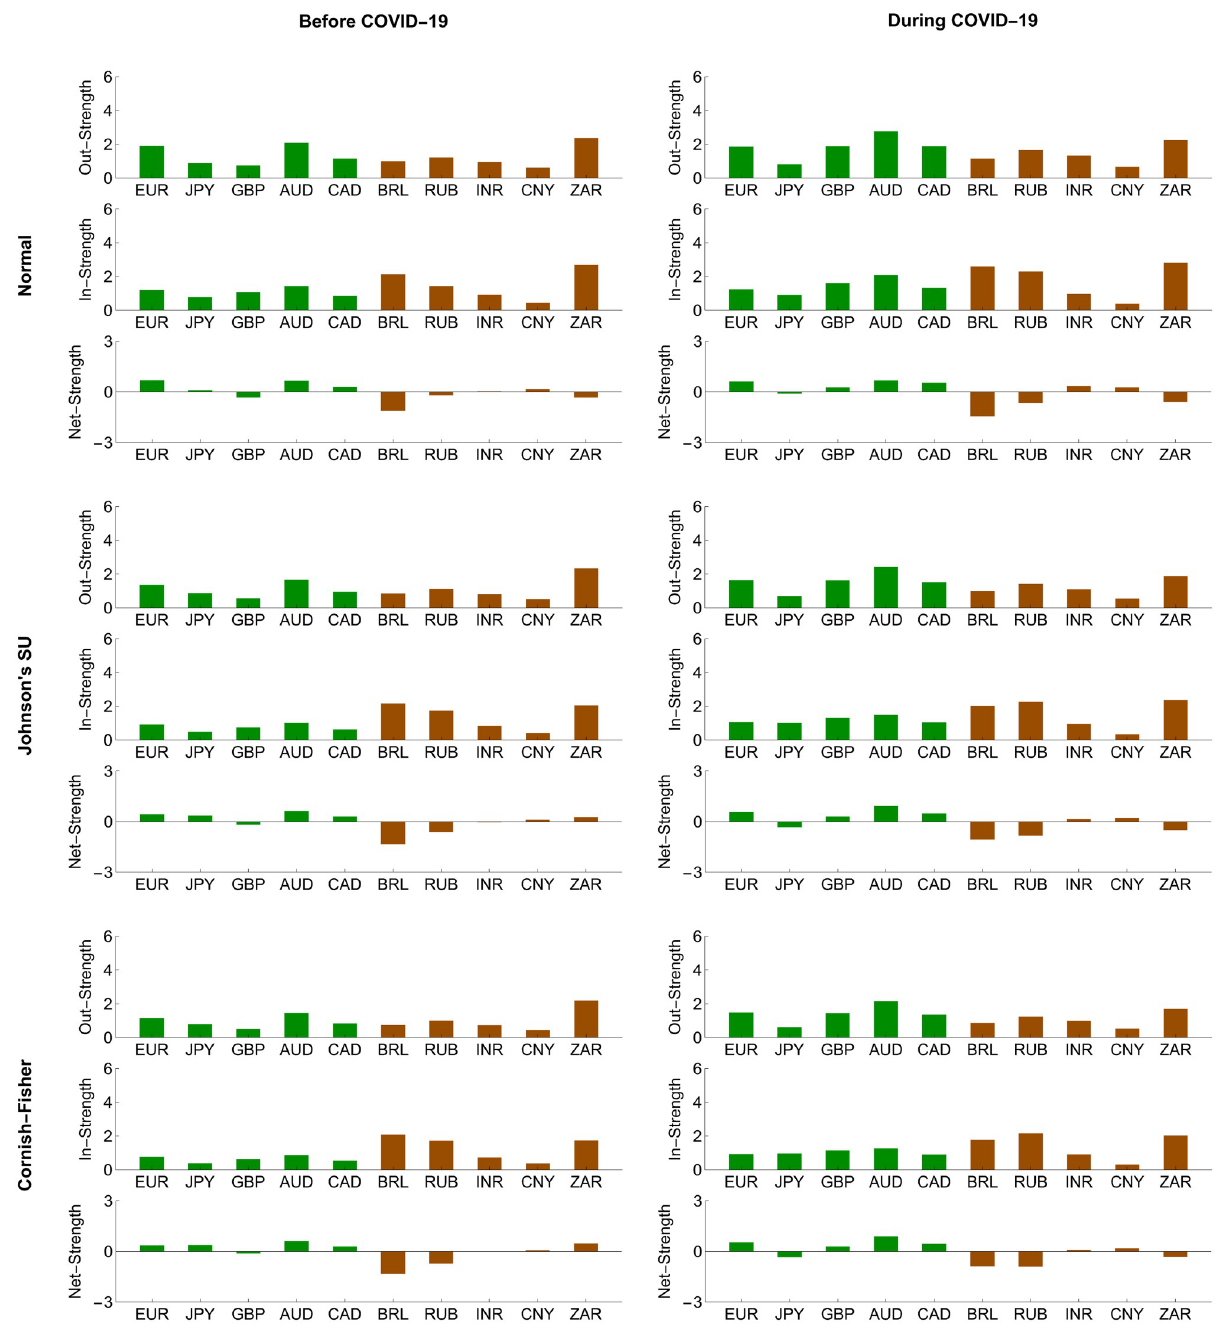
Fig 9. Node strength measures of the conditional tail risk networks based on Δ MCoVaR forecasts. Green and brown represent the advanced and emerging forex markets, respectively. ten forex markets appeared to rise due to the pandemic. As we summarize in Table 10, their average for a given network during COVID-19 also had a larger value than that before COVID-19. Wang and Xie [25] argued that the averaged clustering coefficient reflects the overall tightness of the network. Accordingly, our results indicate that the forex network amid